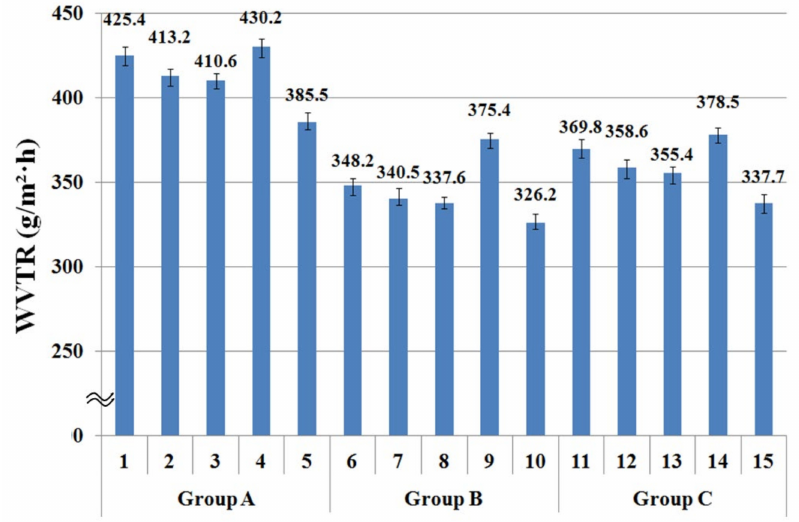
Figure 5. WVTR of the specimens using the upright cup